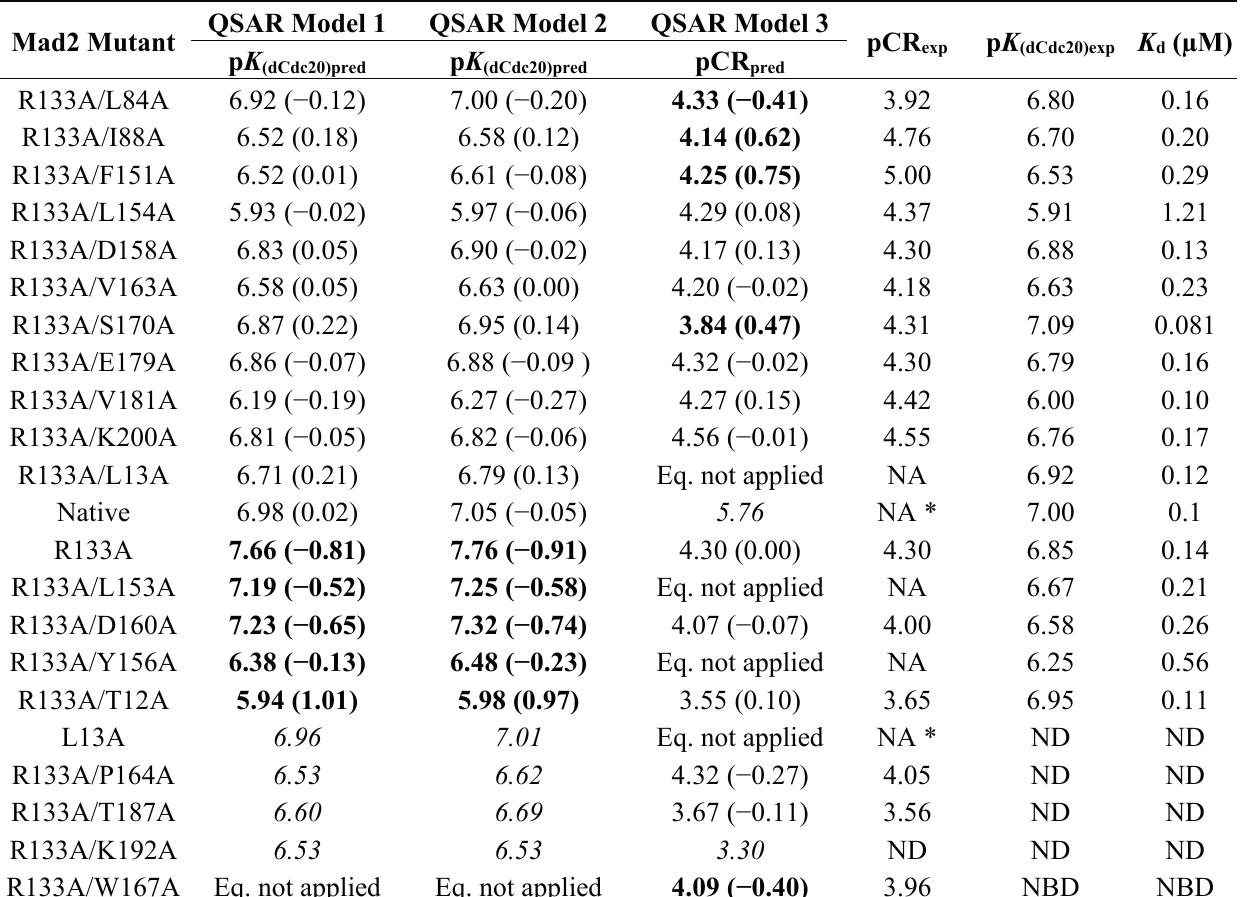
Table 2. Experimental and predicted p K dCdc20 (the common logarithm of inverse binding affinities) and pCR (the common logarithm of inverse conversion rates) of Mad2 native and mutants and residual values obtained by applying QSAR models 1–3 (in brackets). Bold numbers indicate values for test sets and italics indicate predicted values for which corresponding activities were not detected